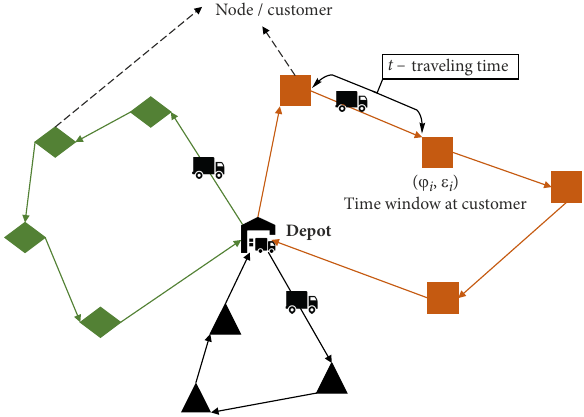
Figure 1. An example about VRPTW (Wang et al. 2020)